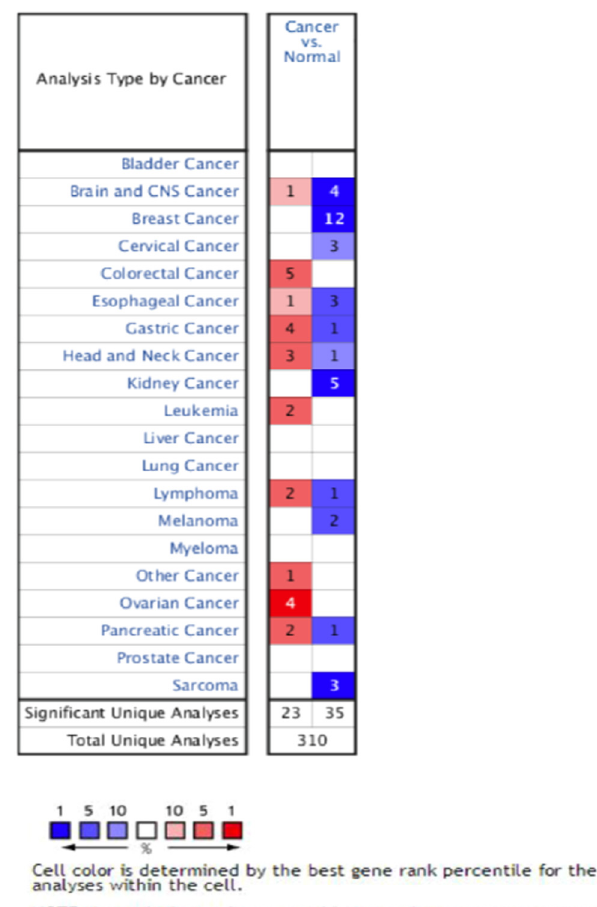
Figure 1: Transcriptional levels of KLK7 in di ff erent types of cancers ( ONCOMINE )